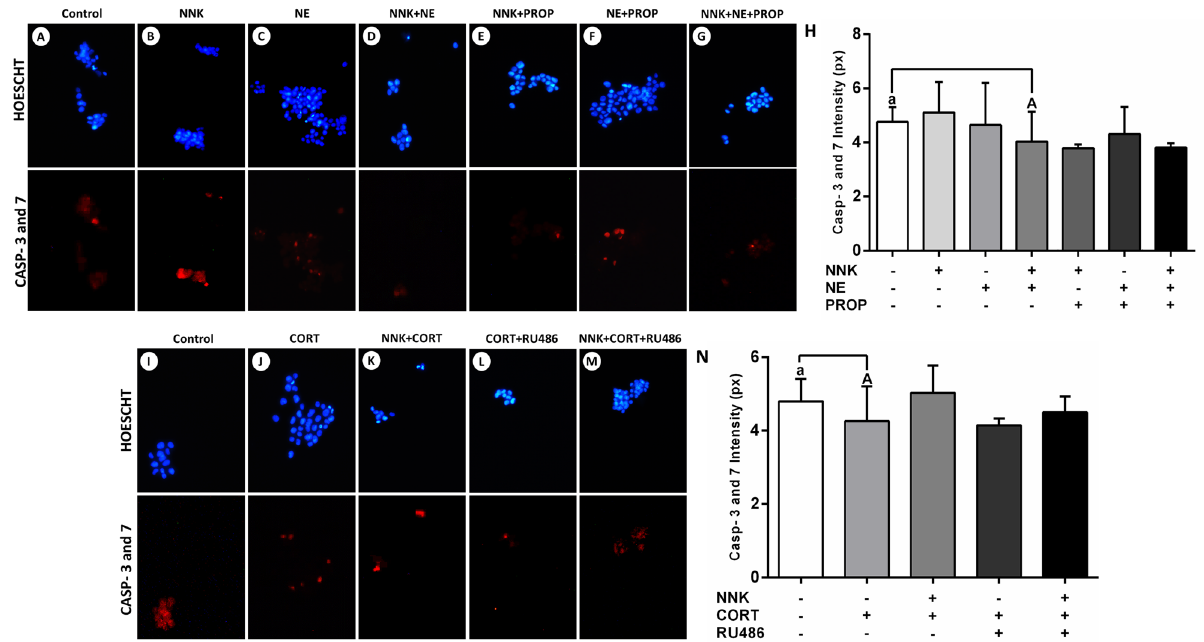
Figure 2. Effects of tobacco-specific nitrosamine NNK and norepinephrine on the activity of the caspases 3 and 7. ( A ) Control. ( B ) NNK. ( C ) Norepinephrine. ( D ) NNK and norepinephrine. ( E ) NNK and propranolol. ( F ) Norepinephrine and propranolol. ( G ) NNK, norepinephrine and propranolol. ( H ) Combined treatment of NNK with norepinephrine inhibited the activity of the pro-apoptotic enzymes. This effect was not abolished by